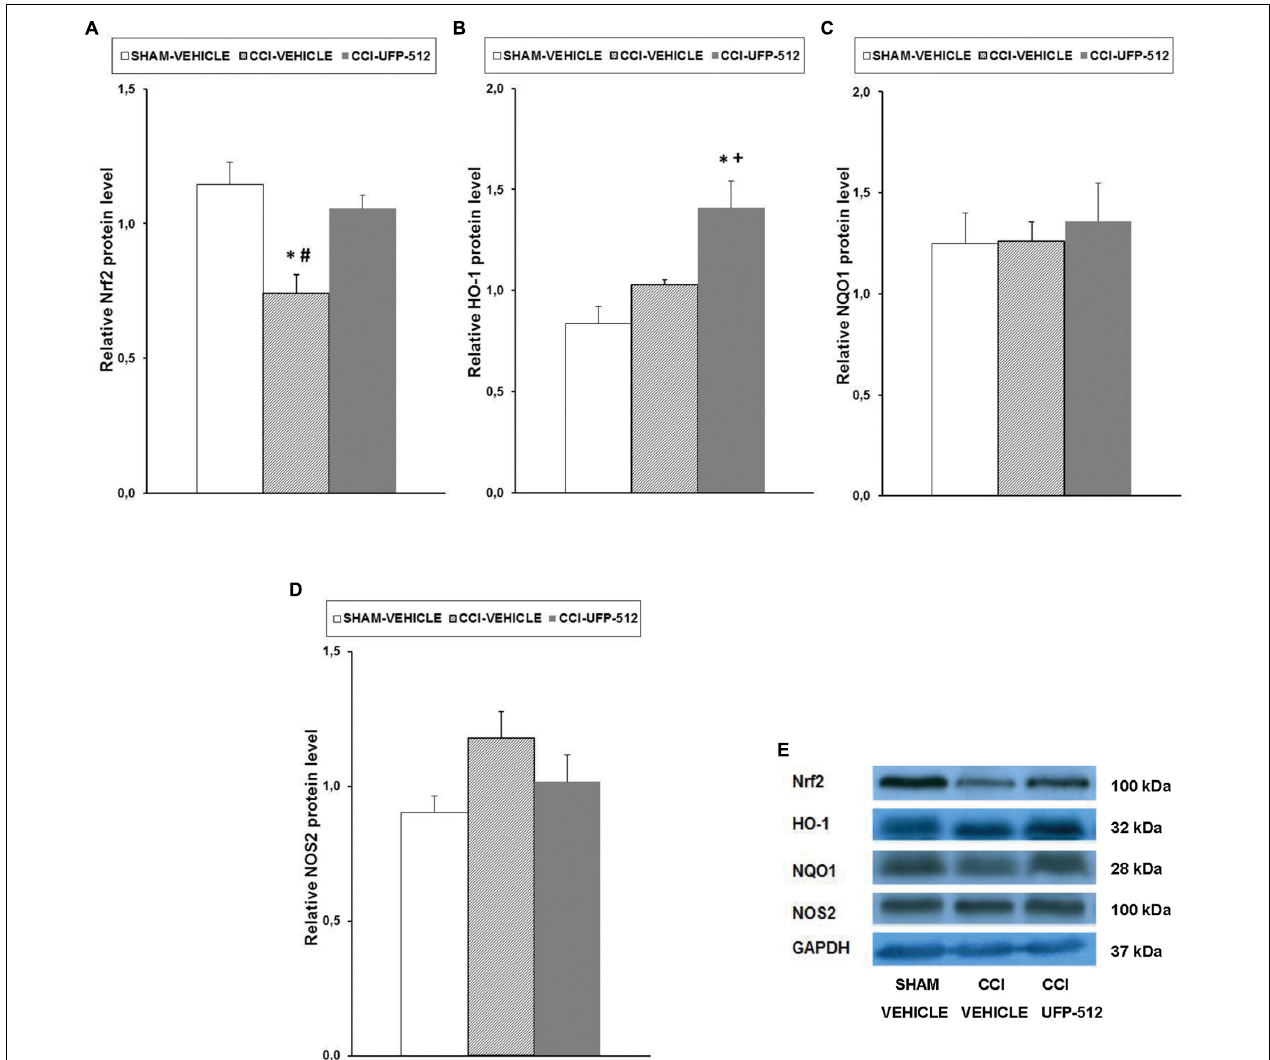
FIGURE 5 | Effects of UFP-512 on the expression of Nrf2, HO-1, NQO1, and NOS2 in spinal cords of animals with neuropathic pain. Protein levels of Nrf2 (A) , HO-1 (B) , NQO1 (C) , and NOS2 (D) in the ipsilateral site of spinal cords of CCI-injured mice treated with UFP-512 (CCI-UFP-512) or vehicle (CCI-vehicle) are represented. Controls corresponding to sham-operated mice treated with vehicle (sham-vehicle) are also shown. For each protein, ∗ indicates significant differences vs. sham-operated mice treated with vehicle, + indicates significant differences vs. CCI-injured mice treated with vehicle, and # indicates significant differences vs. CCI-injured mice treated with UFP-512 ( P < 0.05, one-way ANOVA, followed by the Student–Newman–Keuls test). Representative examples of western blots for Nrf2 (100 kDa), HO-1 (32 kDa), NQO1 (28 kDa), and NOS2 (100 kDa) proteins in which GAPDH (37 kDa) was used as a loading control are also shown (E) . Results are expressed as mean ± SEM; n = 4 samples per